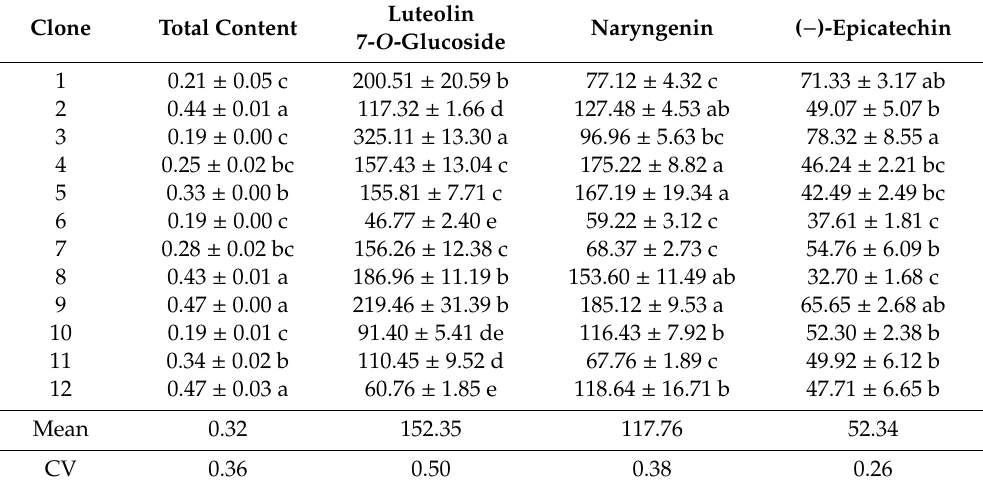
Table 7. The total content (g × 100 g − 1 DW) and chemical composition of flavonoids (mg × 100 g − 1